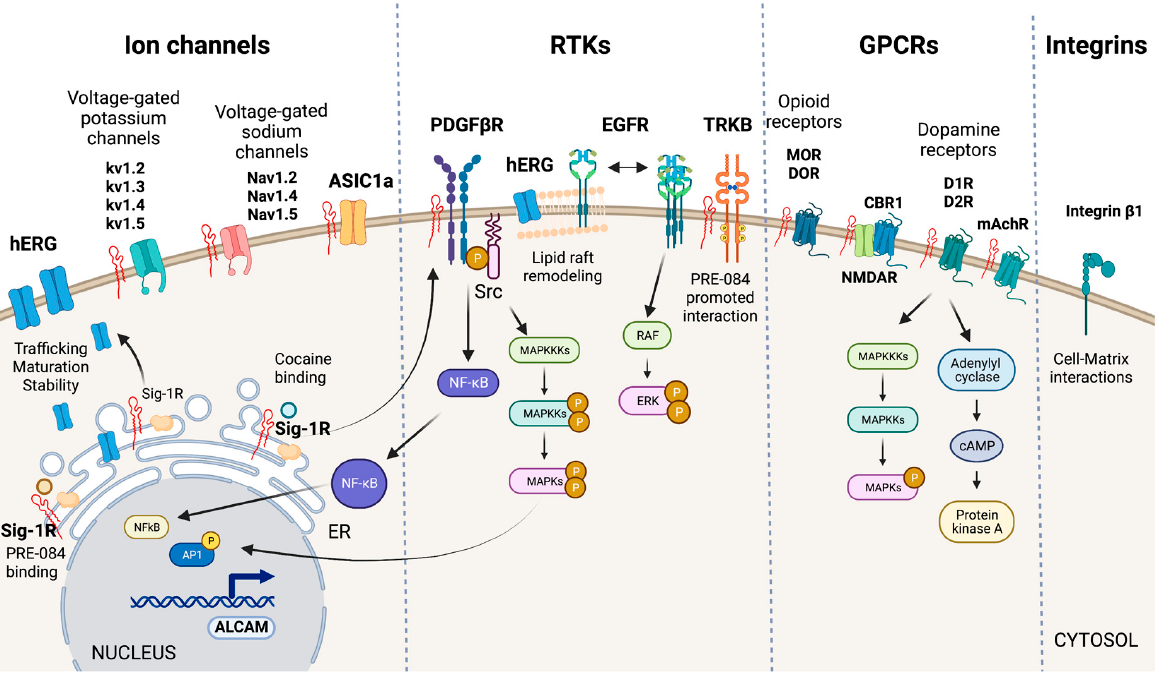
Figure 5. Sig-1R interactions with plasma membrane signaling proteins. Sig-1R interacts with ion channels (hERG, voltage-gated potassium and sodium channels, and ASIC1a), RTKs (PDGF- β R, EGFR, TRKB), GPCRs (MOR, DOR, D1R, D2R, CBR1, and mAchR), and integrins (integrin β 1) at the plasma membrane to regulate their activities and elicit intracellular signaling cascades.